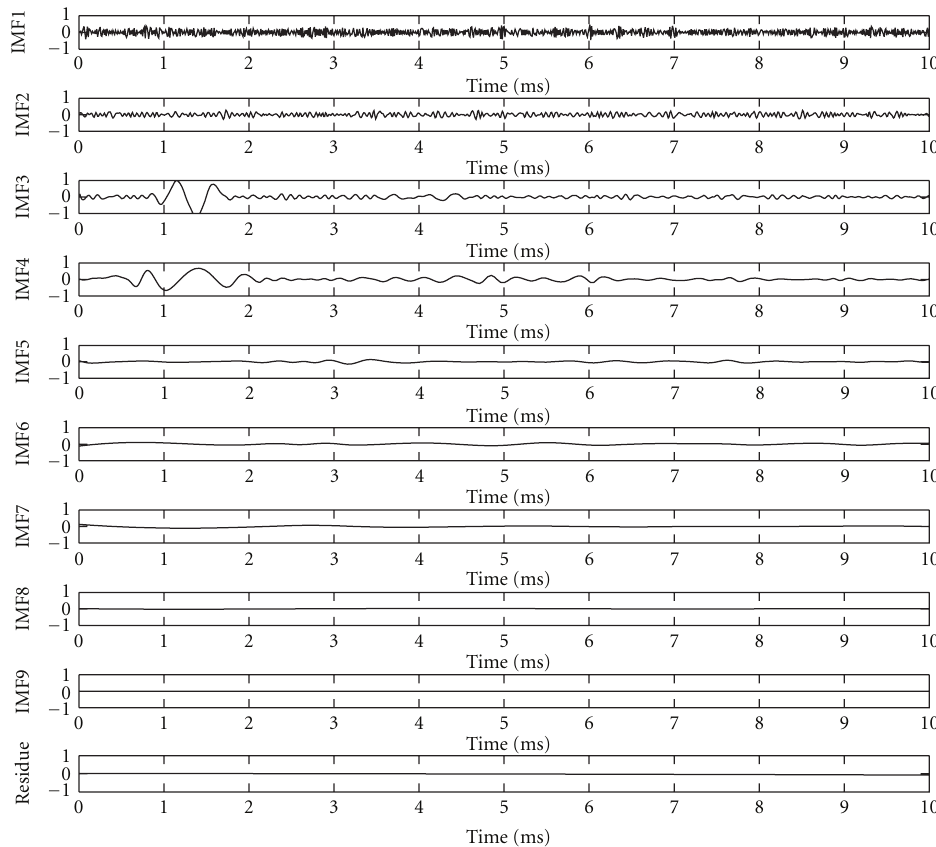
Figure 5: The decomposition result with EEMD.